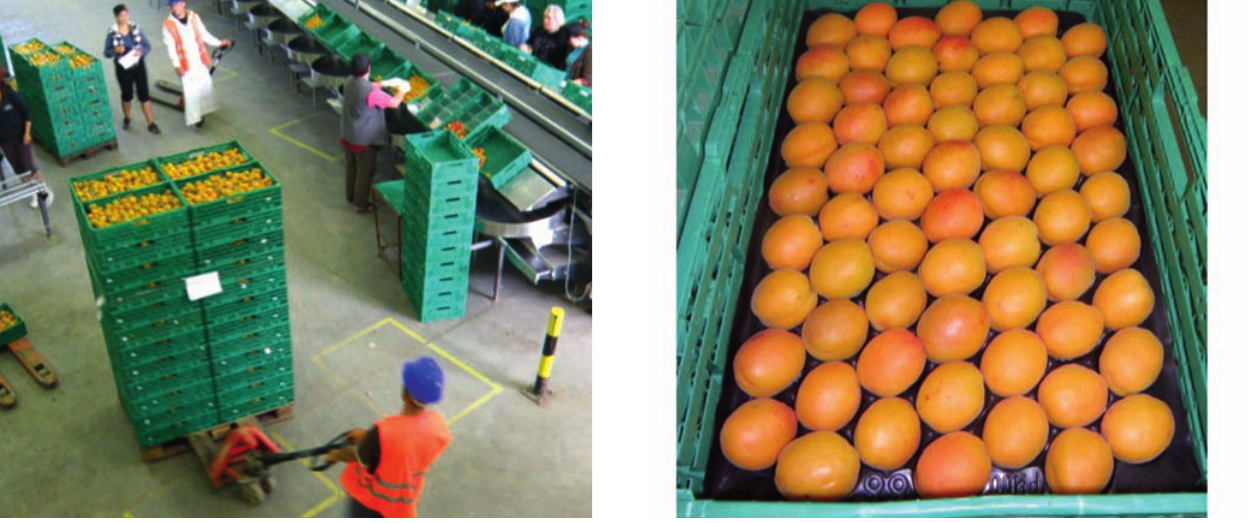
Fig. 7: One-line machine with bilateral round table output Fig. 8: Pack placed in plastic crates